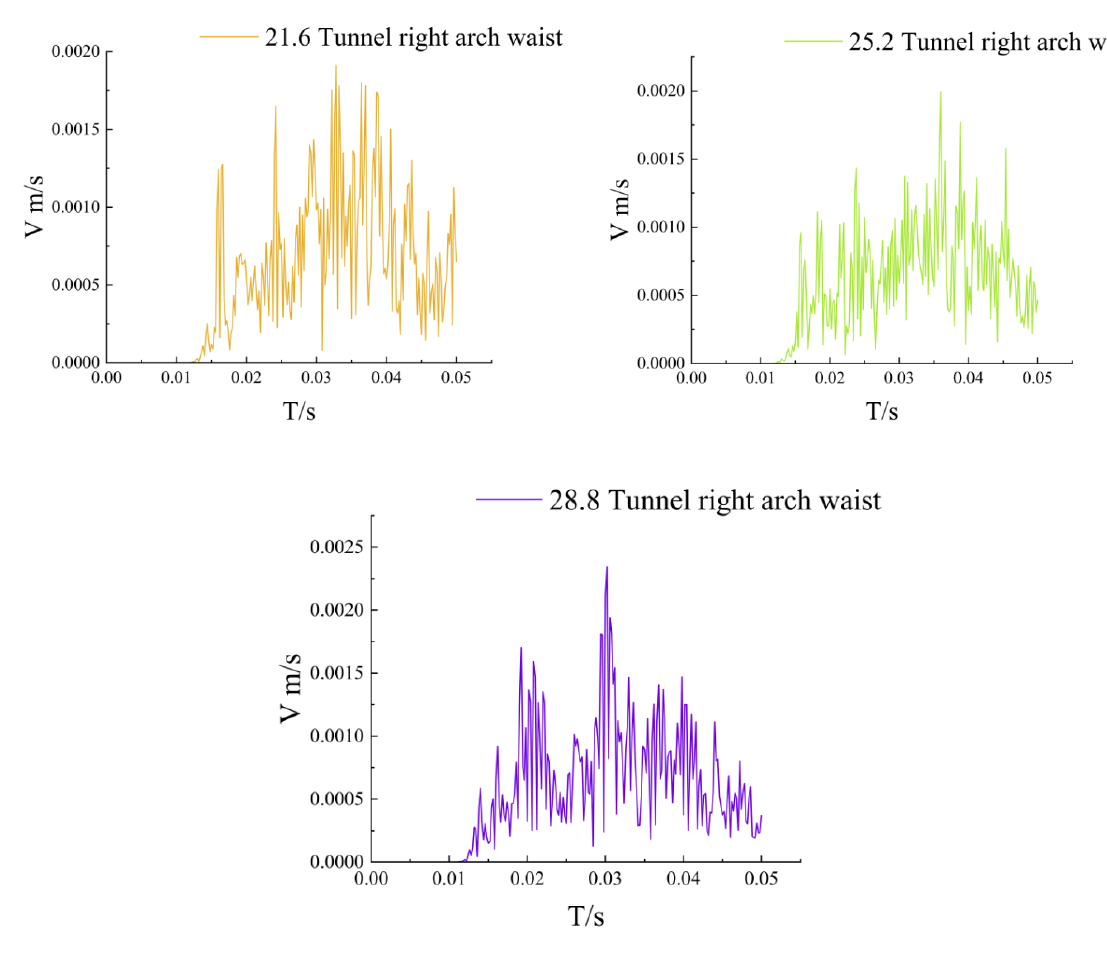
Figure 6. Vibrational velocity curve of the right arch waist of the plain concrete tunnel. Table 6. Peak particle velocity and location with different explosive